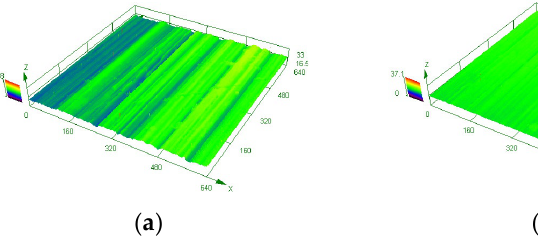
Figure 11. 3D images of LSCM for ( a ) as-received tungsten, ( b ) tungsten in ultrapure water for 60 days and ( c ) tungsten in tap water for 60 days.